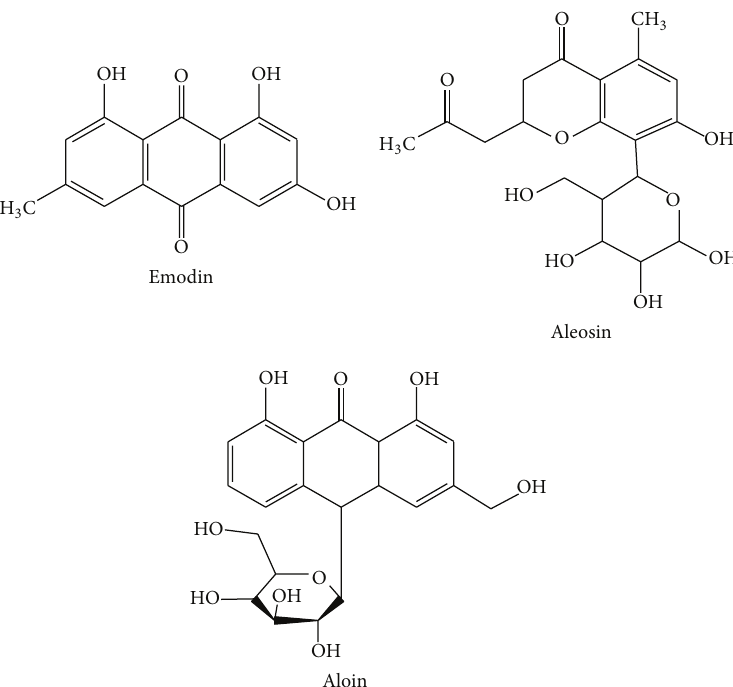
Figure 2: Chemical structures of Aloe vera